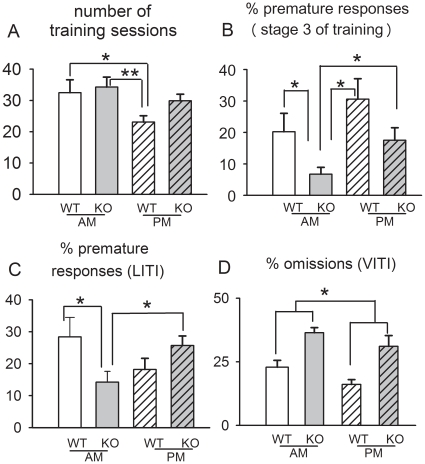
Behaviors of NK1R-/- and wildtype mice in the 5-CSRTT that depend on time of day.(A) the number of sessions needed to train mice to baseline criteria for testing; (B) % premature responses during stage 3 of training; (C) % premature responses in the LITI test; (D) % omissions in the VITI test. Bars show mean ± s.e.m. * P<0.05, ** P<0.01 for comparisons indicated. N = 23–24 per group.